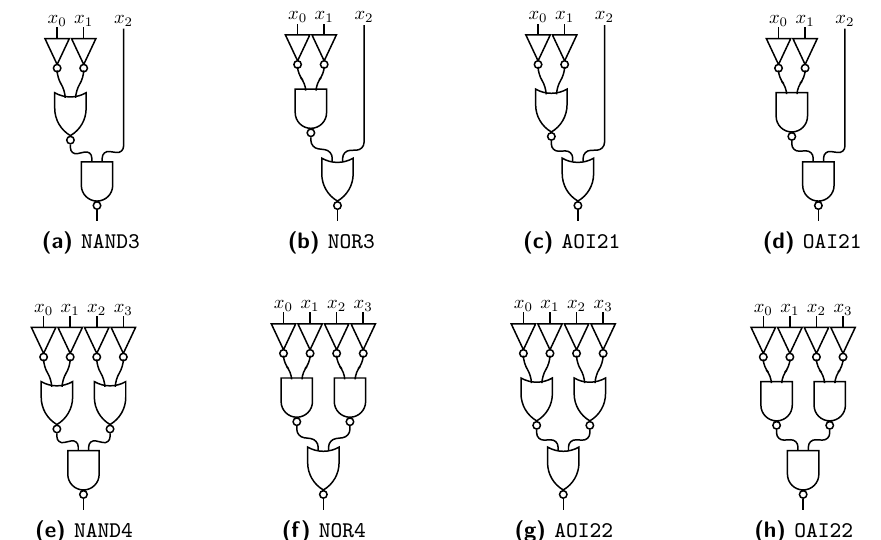
Figure 4: The equivalent sub-circuits for NAND , NOR , OAI and AOI gates with fan-in number of 3 and 4 in the basis of 2-bit NAND , NOR and INV gates.